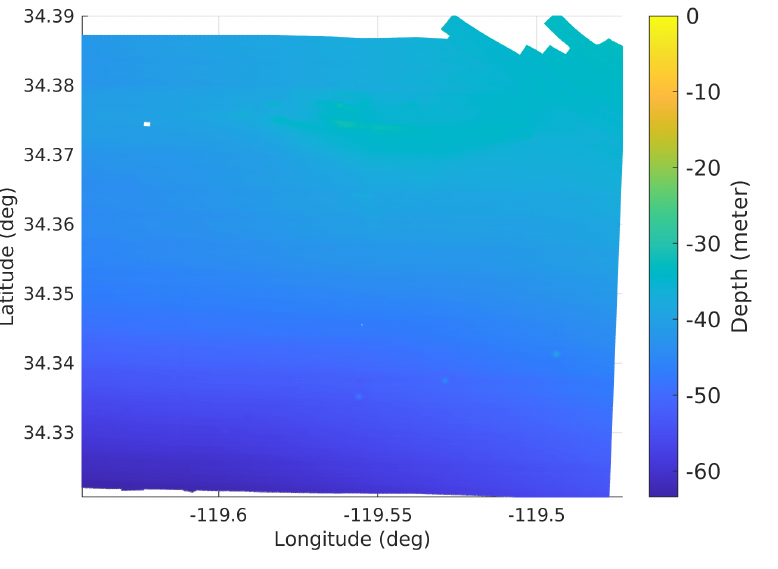
Figure 5. The bathymetric map of the area around the Santa Barbara Channel, United States, in geographic coordinate